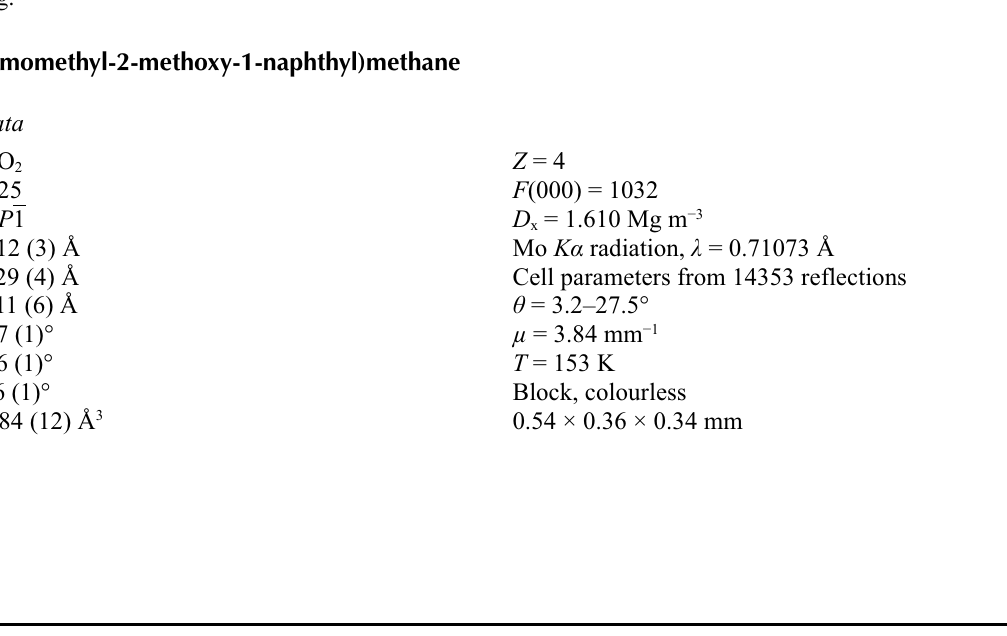
The molecular structure of the title compound, showing 30% probability displacement ellipsoids and the atomic